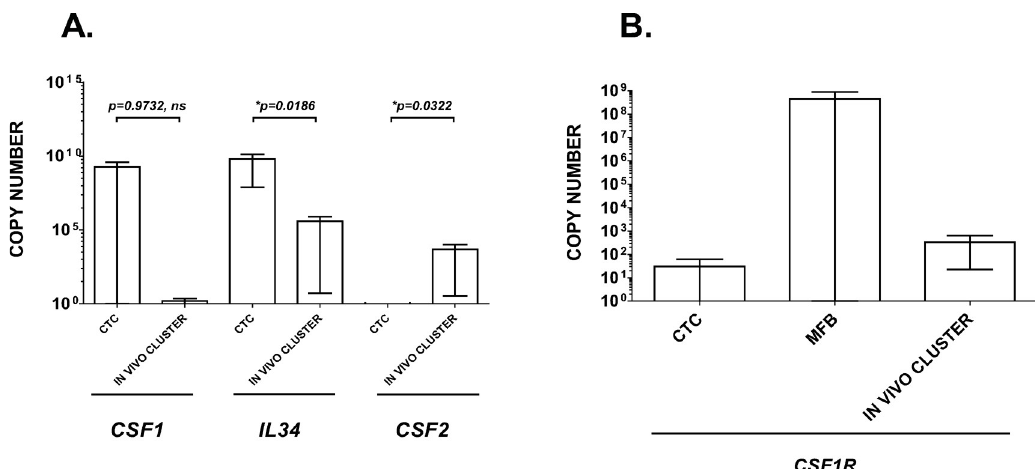
Fig 6. RNA expression of myeloid growth factor signaling ligands and their receptors in uncultured PDAC CTC and M-FB isolated cells and in vivo formed clusters. Uncultured portal blood CTC, M-FB, and in vivo formed CTC+/M-FB+ clusters from PortalBMC of 6 PDAC patients were FACS isolated and collected into RNALater, and then extracted and analyzed for CSF2 , CSF1 , IL34 , CSF1R , and CSF2R RNA expression by real-time RT-PCR. ( A ) CSF1 (M-CSF) RNA expression was elevated in isolated CTC and CSF2 (GM-CSF) RNA expression was elevated in vivo CTC+M-FB clusters. High variability was seen in isolated CTC CSF1 RNA expression, complicating interpretation of statistical analyses. CSF2 expression was higher in in vivo clusters compared to CTC alone (p = 0.0322). Though found elevated in both, IL34 RNA expression was higher in isolated CTC than in in vivo clusters (p = 0.0186). ( B ) M-CSF/IL-34 receptor CSF1R mRNA expression was detectable in CTC, in vivo clusters, and M-FB, with the expression highest but most variable in M-FB. CSF2R RNA expression was not detected in this sample set. Due to limitations in uncultured cell isolate numbers, RNA for CXCL8 (IL8) and CXCR2 were not analyzed. Bars depict mean of values and error bars indicate standard error from the mean.